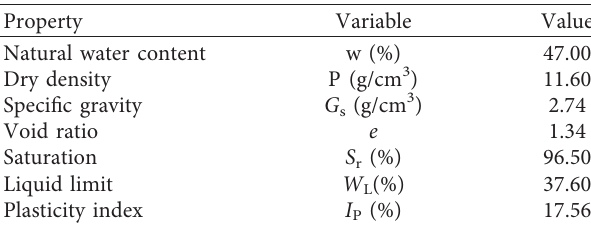
Figure 2: Sketch of the new sample preparation device. The numbers in the figure indicate: 1. Water drilling rig; 2. Adjusting handle; 3. Lifting bracket; 4. Adapter; 5. Straight rod rotary cutter head; 6. Screw rod cutter head; 7. Sample barrel; 8. Sample barrel support; 9. Bottom turntable; 10. Turntable motor; 11. Waste soil bucket; 12. Lateral single-opening ring knife; 13. Lateral double- opening ring Table 1: Physical properties of undisturbed soft clay.